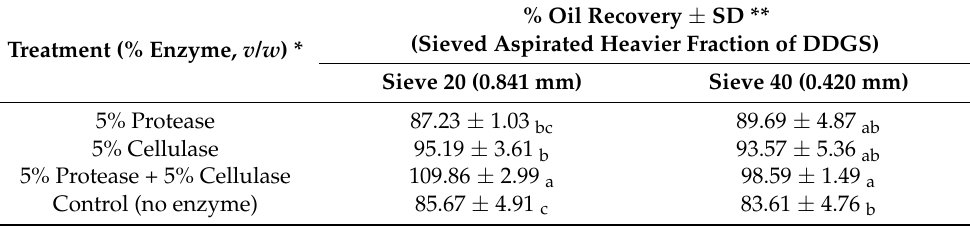
Table 4. Effects of different fractions of DDGS on oil recovery using enzymes.